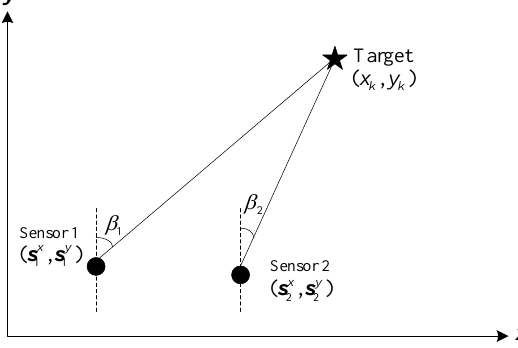
Figure 1. Geometric configuration of multi-sensor BOT.